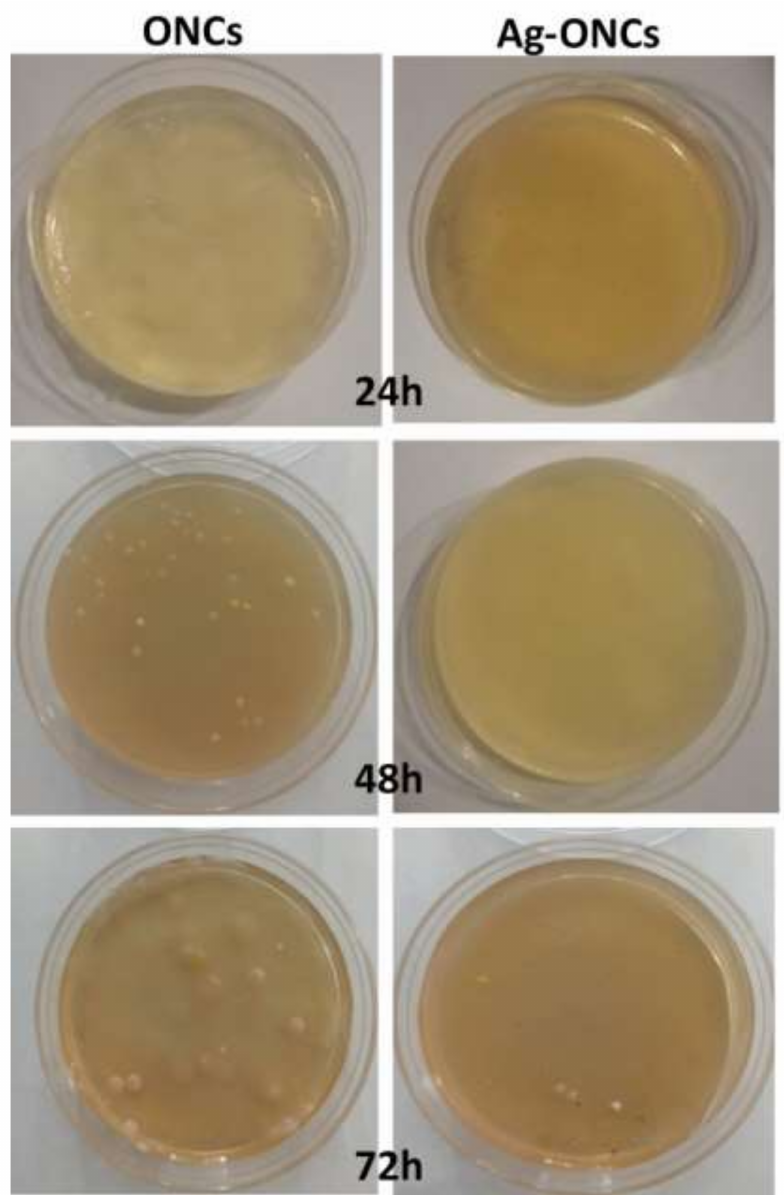
Figure 4. Comparison of antibacterial activity against E. coli of ONCs and Ag–ONCs nanocomposite after different incubation